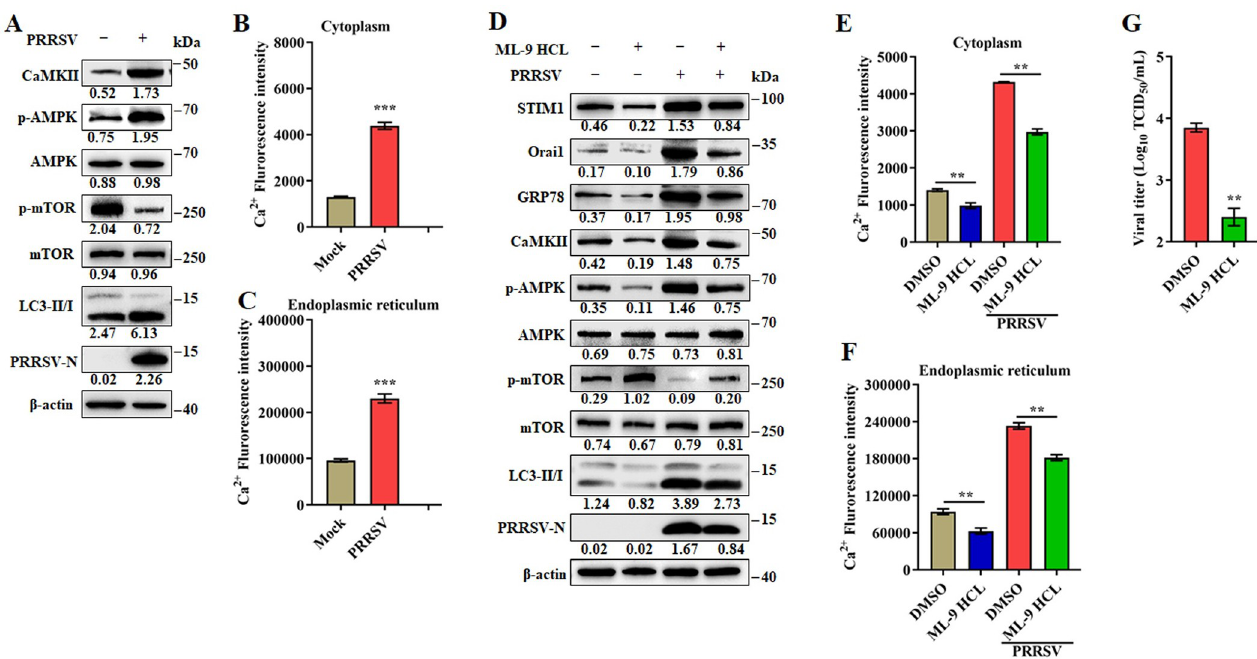
Fig 9. Ca 2+ promotes PRRSV replication in pulmonary alveolar macrophages (PAMs). (A-C) PAMs were infected with PRRSV (MOI = 0.1) for 24 h. ( A ) Cell lysates were analyzed by western blotting for CaMKII, p-AMPK, AMPK, p-mTOR, mTOR, LC3-I/II, PRRSV-N, and β -actin. ( B ) Cytoplasmic and ( C ) ER Ca 2+ levels were determined by fluorescence of Fluo-8. (D-G) PAMs were infected with PRRSV (MOI = 0.1) and treated with 25 μ M ML-9 HCL or DMSO for 24 h. ( D ) Cell lysates were analyzed by western blotting for STIM1, Orai1, CaMKII, p-AMPK, AMPK, p-mTOR, mTOR, LC3-I/II, PRRSV-N, and β -actin. ( E ) Cytoplasmic and ( F ) ER Ca 2+ levels were determined by fluorescence of Fluo-8. ( G ) TCID 50 of PRRSV in cell supernatants. The protein levels were quantified by Image J and normalized to β -actin. The data are representative of results from three independent experiments. Error bars indicate the mean ( ± SD) of three repeats. * , p < 0.05; ** , p < 0.01; and *** , p < 0.001.